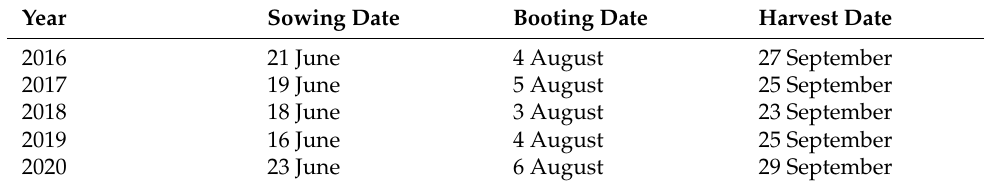
Table A2. The recorded dates of sowing, booting and